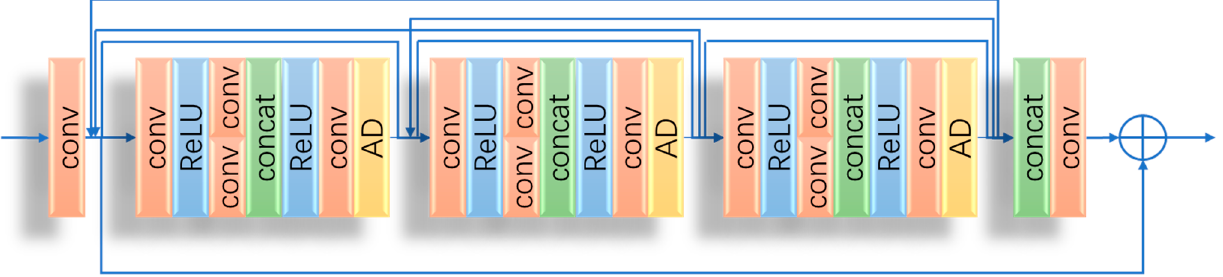
Figure 11. The structure of Restore-Net.